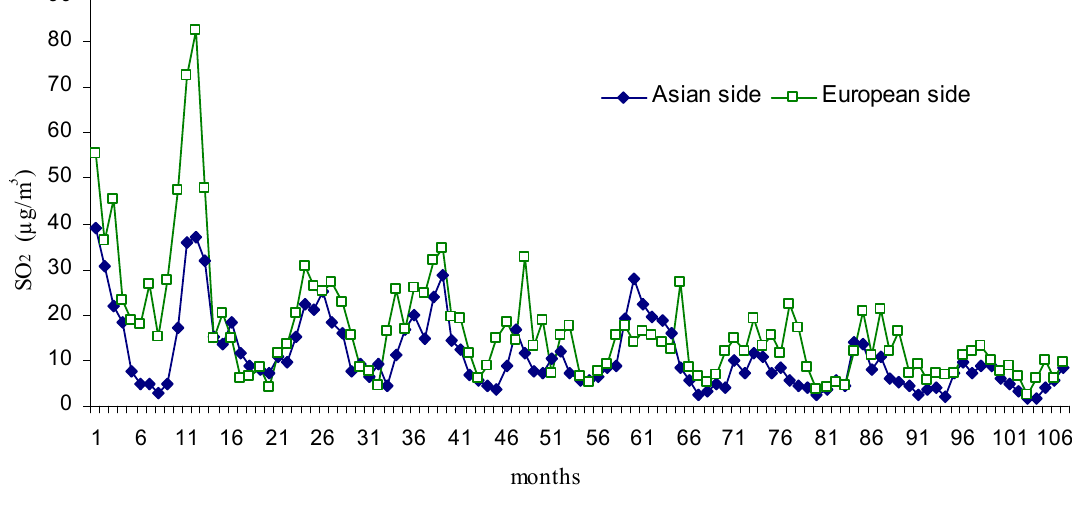
(µg/m 3 ) during the study period (Jan 2002–Dec 2010). 2